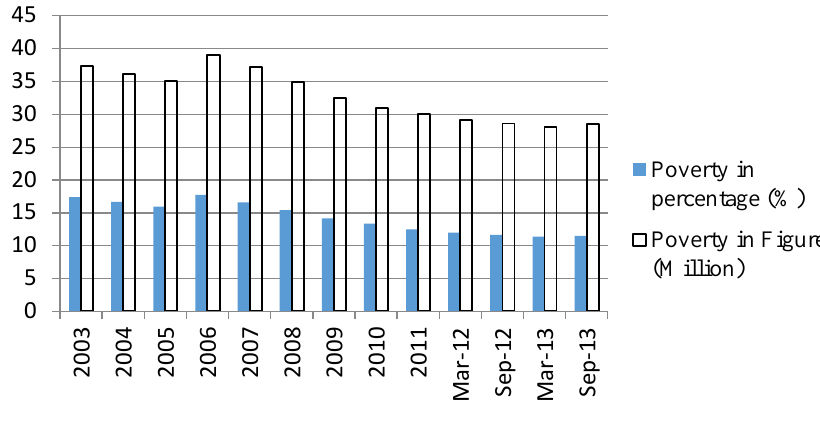
Figure 1 The amount and percentage of poverty in Indonesia, 2003-2013 Source : Statistic Indonesia